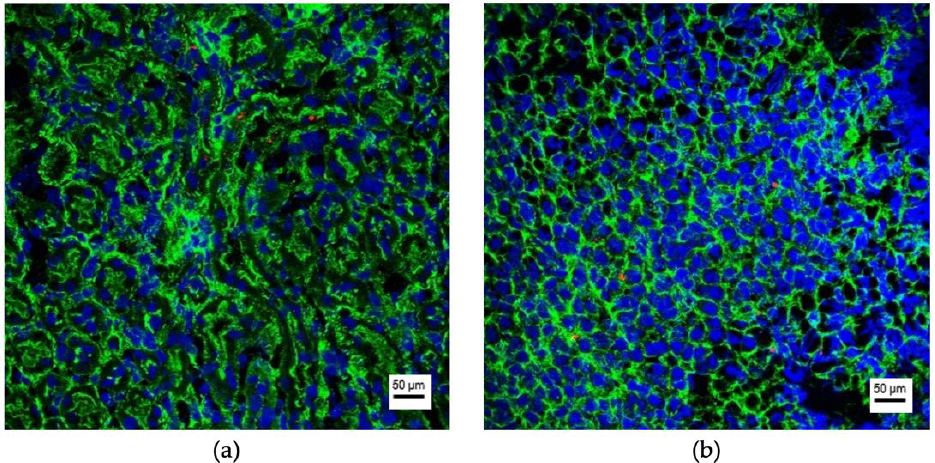
Figure 5. Uptake of HCV-29 EVs in kidneys and adrenals. Representative images of the kidney ( a ) and the adrenal ( b ) 12 h after i.v. injection of PKH26-labeled HCV-29 EVs. The cytoskeleton of the cells is marked in green (Phalloidin-Alexa488) and their nuclei are marked in blue (DAPI). EVs appear in red (PKH26). Resolution 200-fold; scale bar = 50 μm.